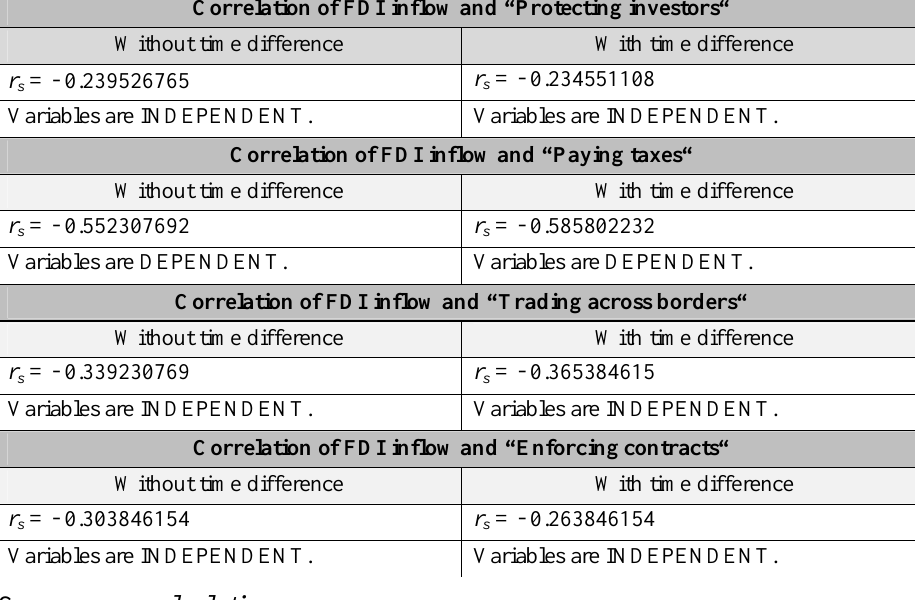
Table 5 - Summary of testing